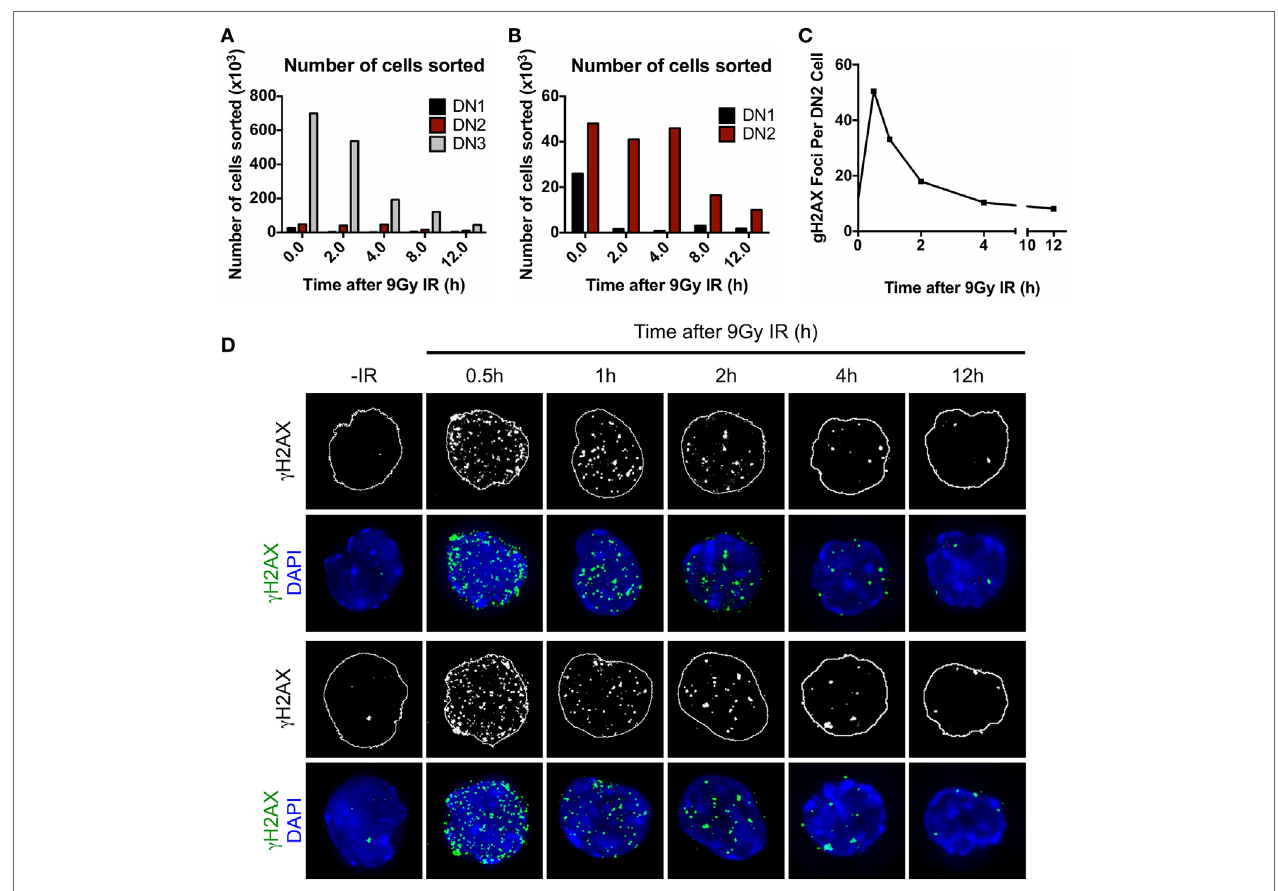
FigUre 6 | Characterization of DN pro-T cells in vivo response to ionizing radiation (IR). (a) Number of DN1, DN2, and DN3 pro-T cells; (B) number of DN1 and DN2 pro-T cells only that were recovered at different time points 0–12 h after irradiation with 9 Gy. (c) Average number of γ H2AX IR-induced foci (IRIF) per nucleus and (D) representative images of DN2 nuclei stained for γ H2AX IRIF and DAPI, corresponding to cells irradiated in vivo and isolated 0–12 h post